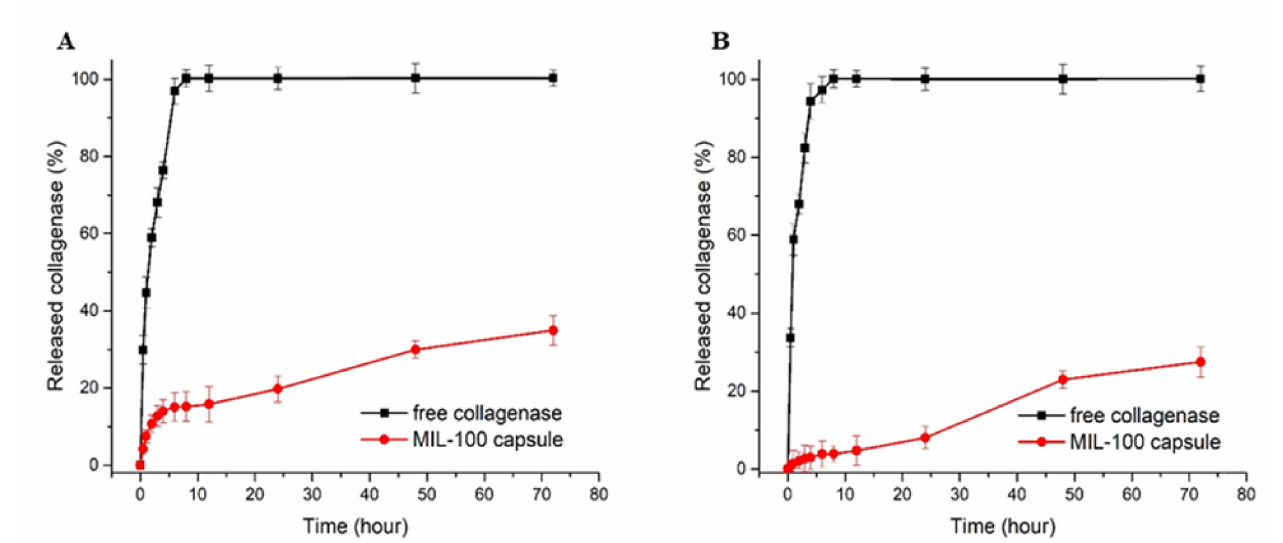
Figure 6. Collagenase release profiles from free enzyme and collagenase-loaded MIL-100 capsules at pH 7.4 ( A ) and pH 5 ( B